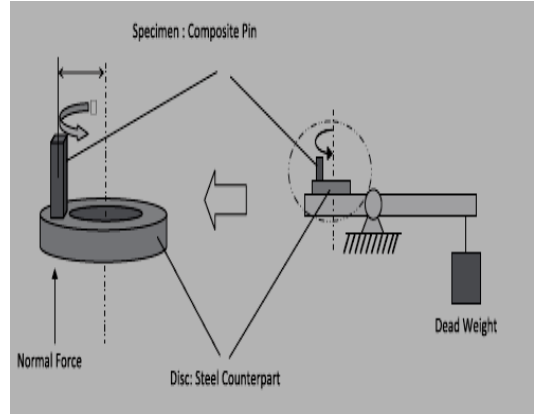
Fig. 1: The pin-on-disc wear